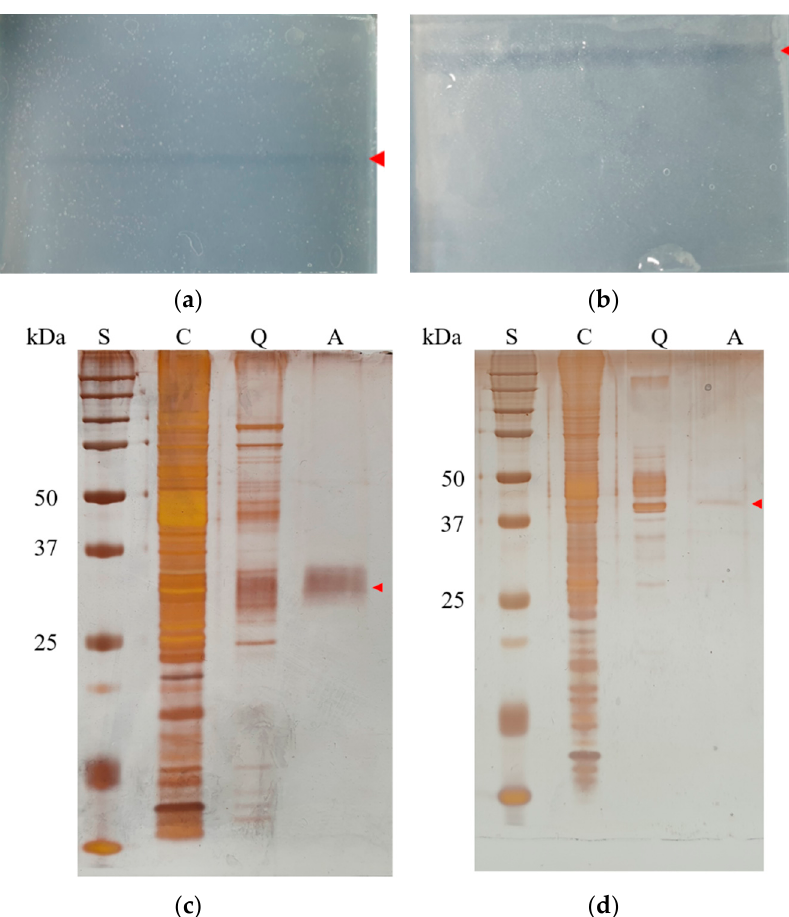
Figure 4. Activity staining of Est8L ( a ) and Est13L ( b ) onto the agar strips after native-PAGE and analysis of recovered Est8L ( c ) and Est13L ( d ) eluted from the activity-stained agar strips using SDS- PAGE and staining with silver nitrate. Native-PAGE was performed using the HiTrap Q fraction with the highest activity, and activity staining was performed according to the procedure described in the Materials and Methods. Red arrows in ( a , b ) represent the active bands for the enzymes. Red arrows in ( c , d ) indicate the predicted positions of Est8L and Est13L, respectively. S, size markers; C, crude extracts; Q, fraction pools from HiTrap Q column chromatography; A, pools from activity staining.